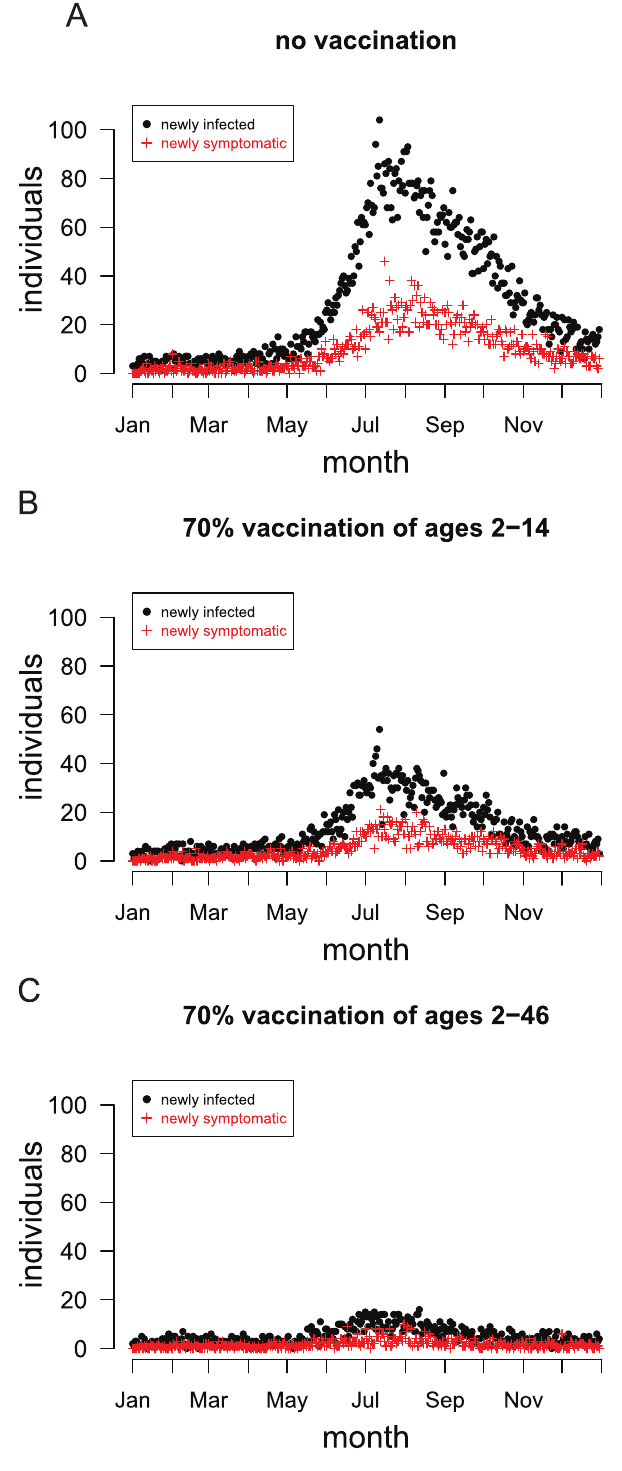
Figure 4. Simulated dengue incidence in a single year. Each plot shows the daily number of newly infected and symptomatic people from a single representative stochastic simulation. (A) A simulation in which no vaccination took place (baseline scenario). (B) A randomly selected 70% of the population aged 2 to 14 years was vaccinated. (C) A randomly selected 70% of the population aged 2 to 46 years was vaccinated. The vaccine confers protection to 70% of vaccinees in the